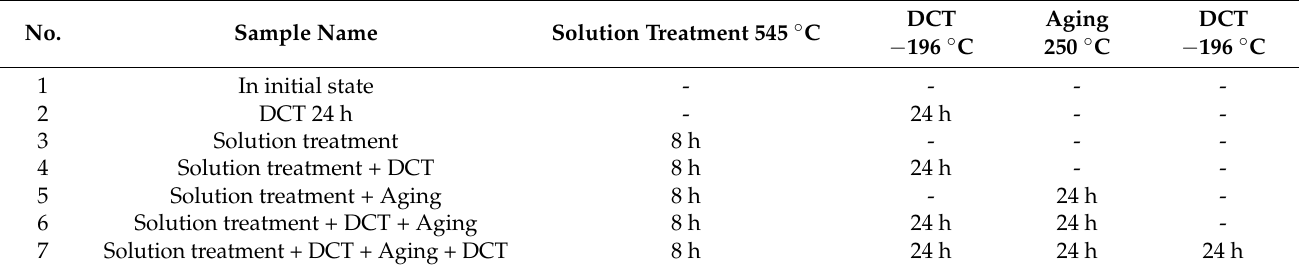
Table 1. Heat treatment and deep cryogenic treatment (DCT) parameters of Mg-Y-Nd magnesium alloy.